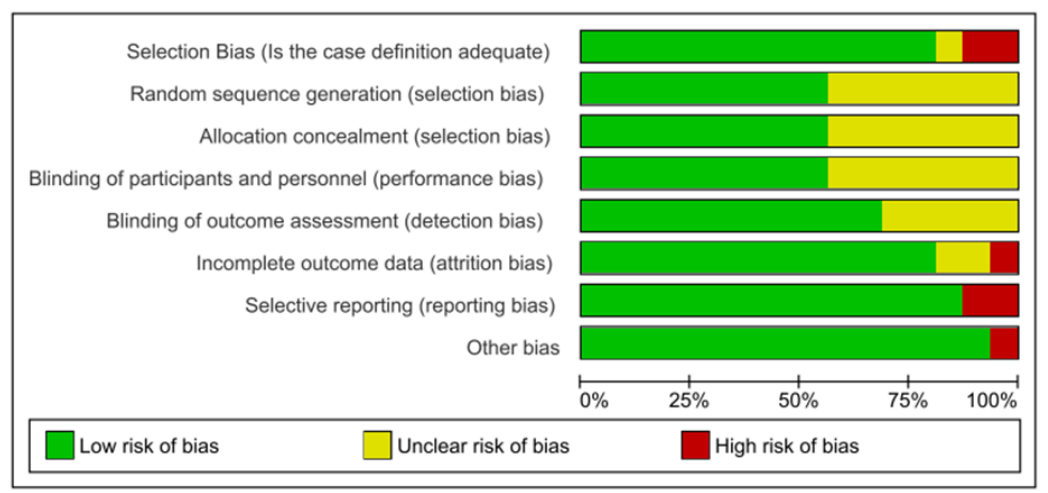
Figure 5. Overall summary of risk bias for each type of bias for all 16 studies; green = low risk of bias, yellow = unclear risk of bias, red = high risk of bias.